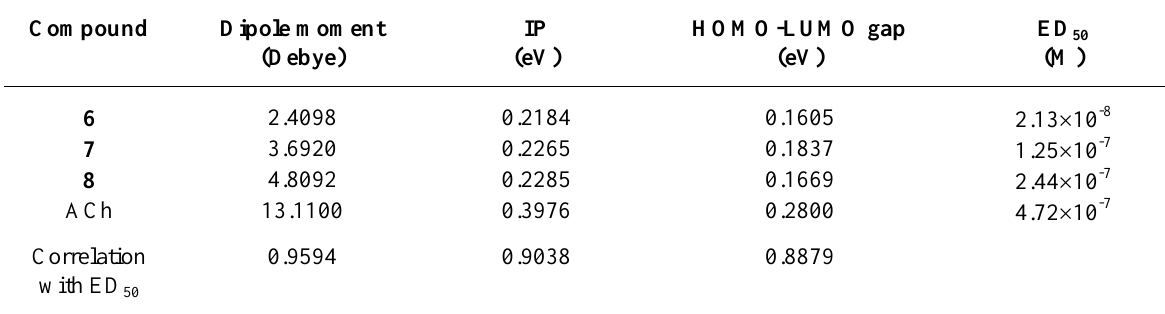
Table 5. Calculated molecular descriptors derived from B3LYP/6-31g(d) as correlated with the vasorelaxant ED 50